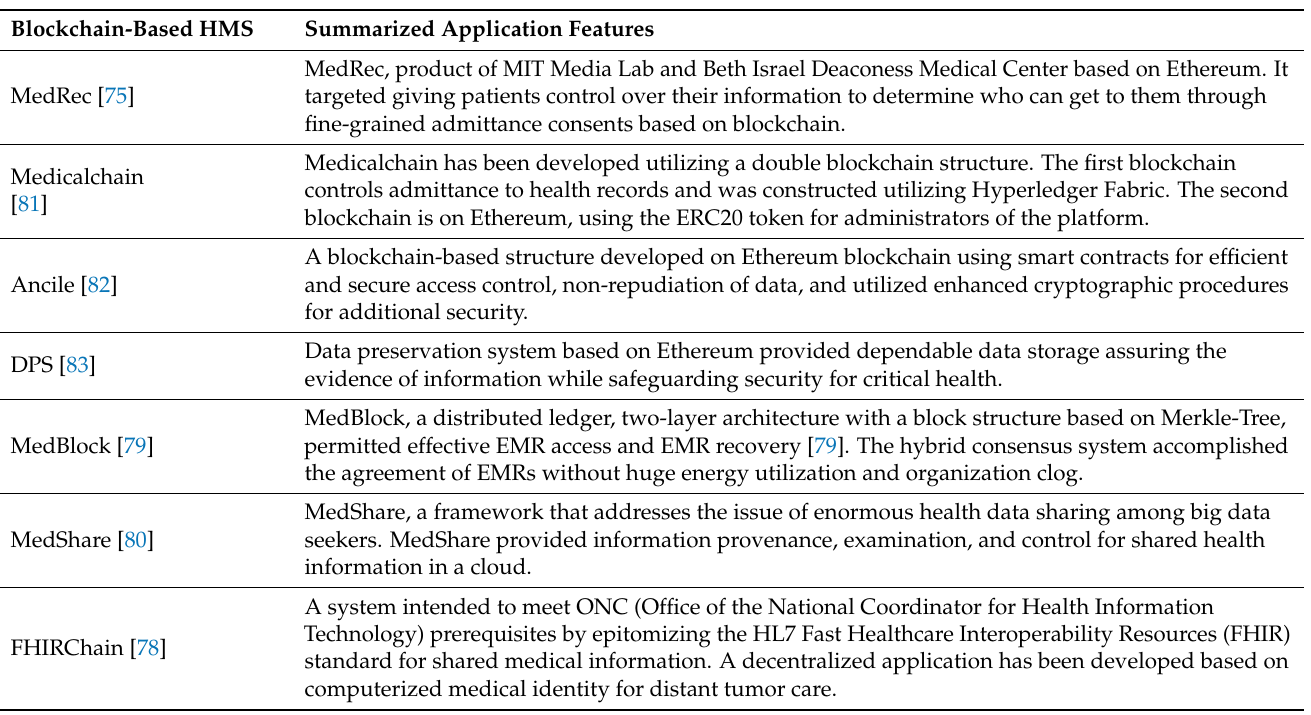
Table 4. Summary of popular blockchain-based